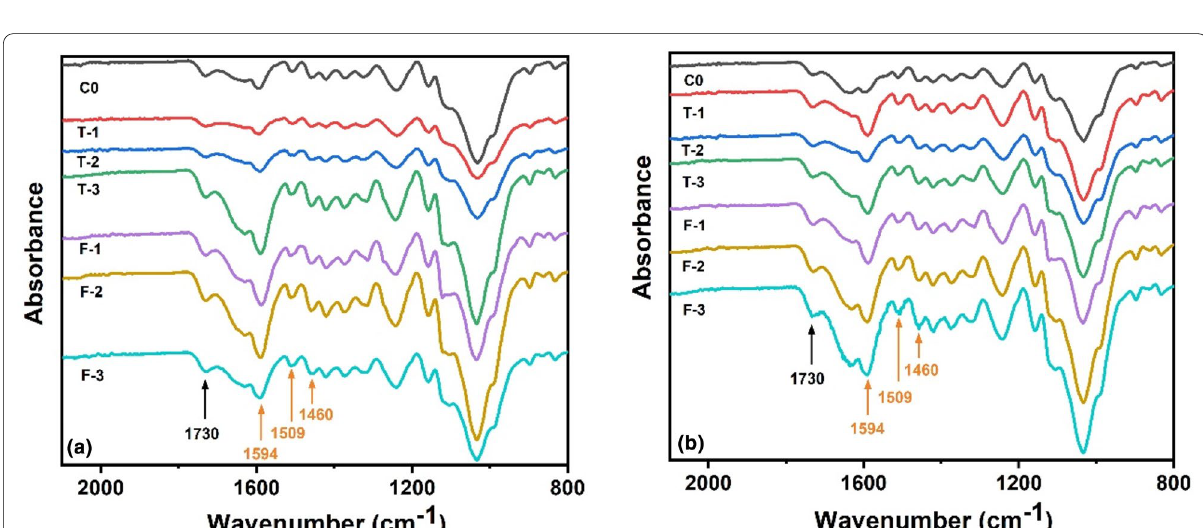
Fig. 3 FT-IR spectra of bamboo after freeze–thaw treatment with different moisture content. ( a From the outer layer of bamboo, b from the inner layer of